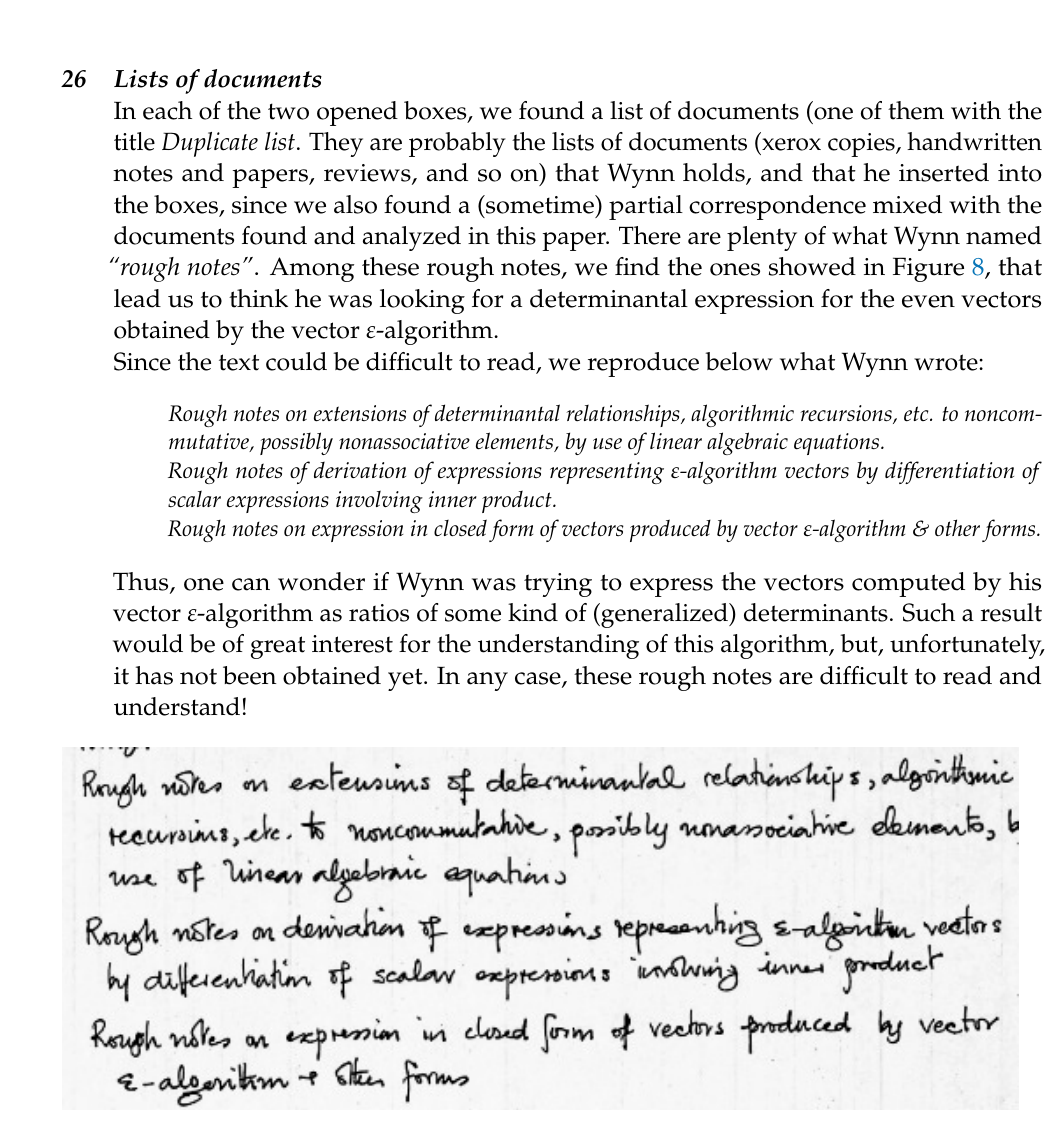
Figure 8. Notes of Peter Wynn on the vector ε